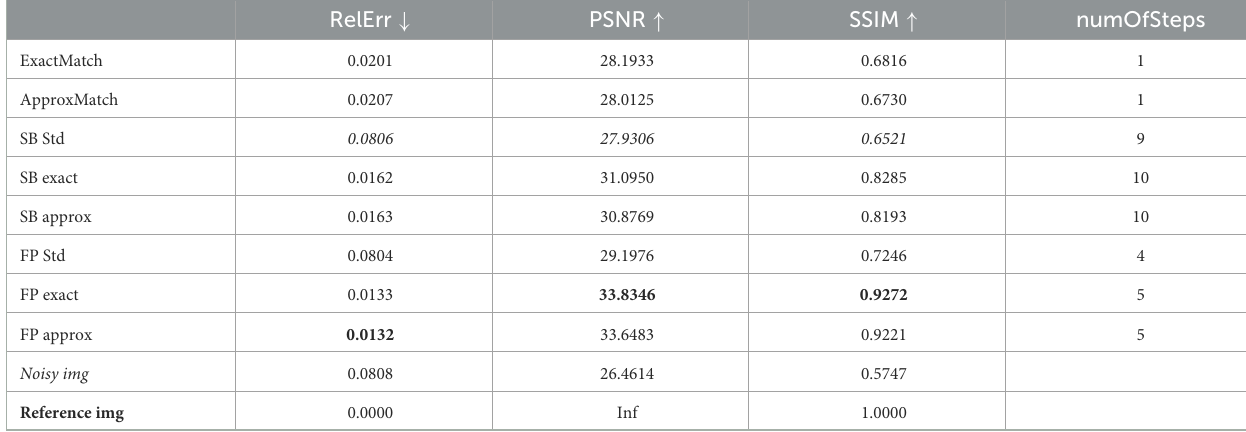
TABLE 1 Case 1: comparison when the matching technique is used with the original image as the